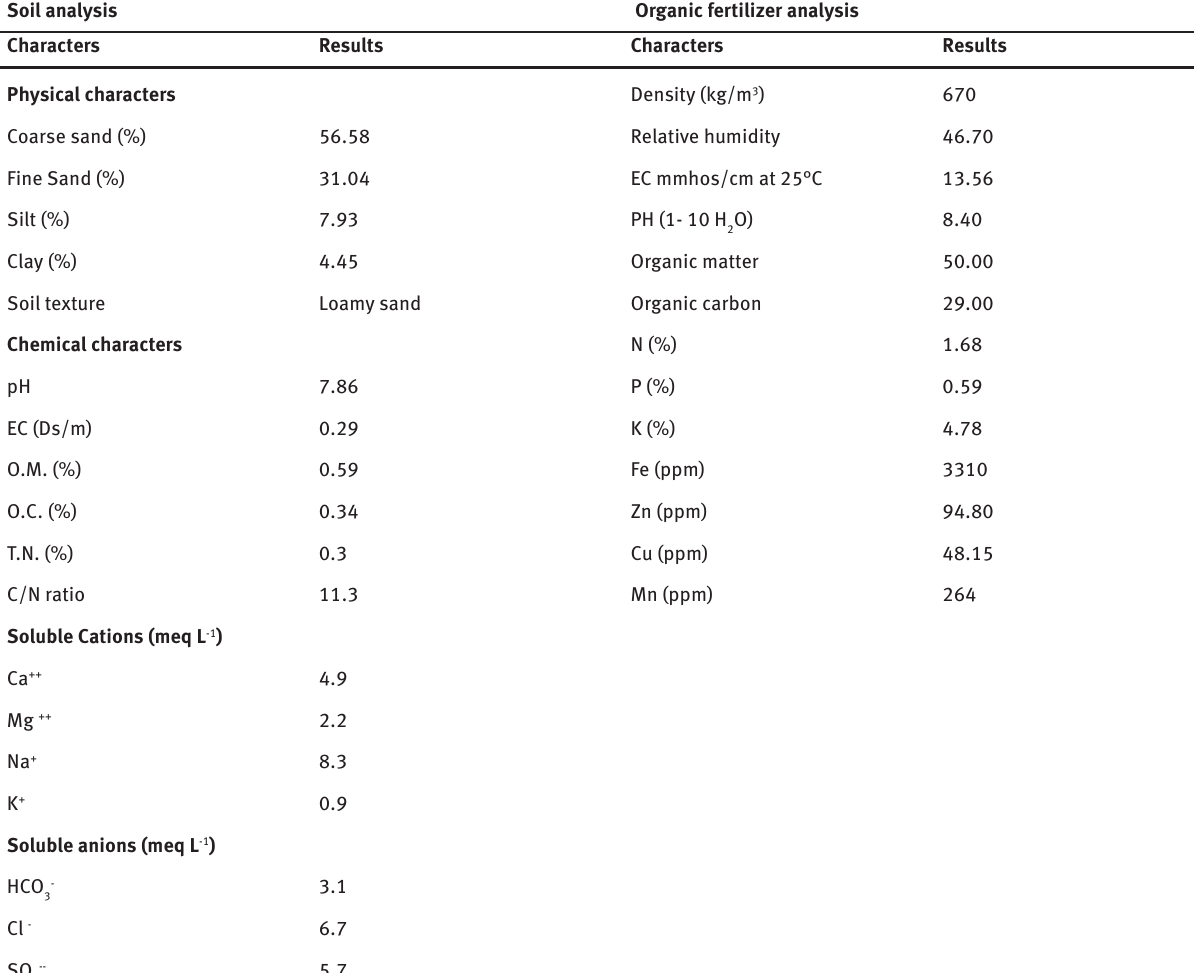
Table 1: Physical and chemical characters of soil and organic fertilizer used in the current study. Soil